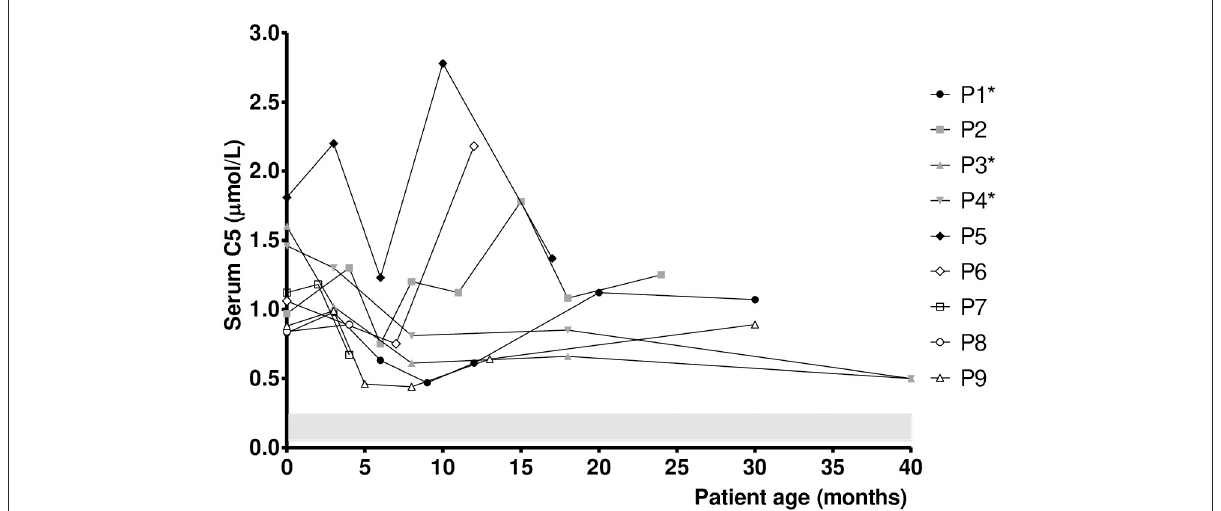
FIGURE1 Serum C5 values in SBCADD patients. For each subject, the first time point shows the serum C5 value detected upon NBS recall before starting the L-carnitine treatment (100 mg/kg/day). Subsequent time points show serum C5 value after starting with L-carnitine treatment. C5 reference range is highlighted (shaded area). * Data for P1 at 24 months, P3 and P4 at 12 and 24 months were not collected due to COVID19 pandemic.